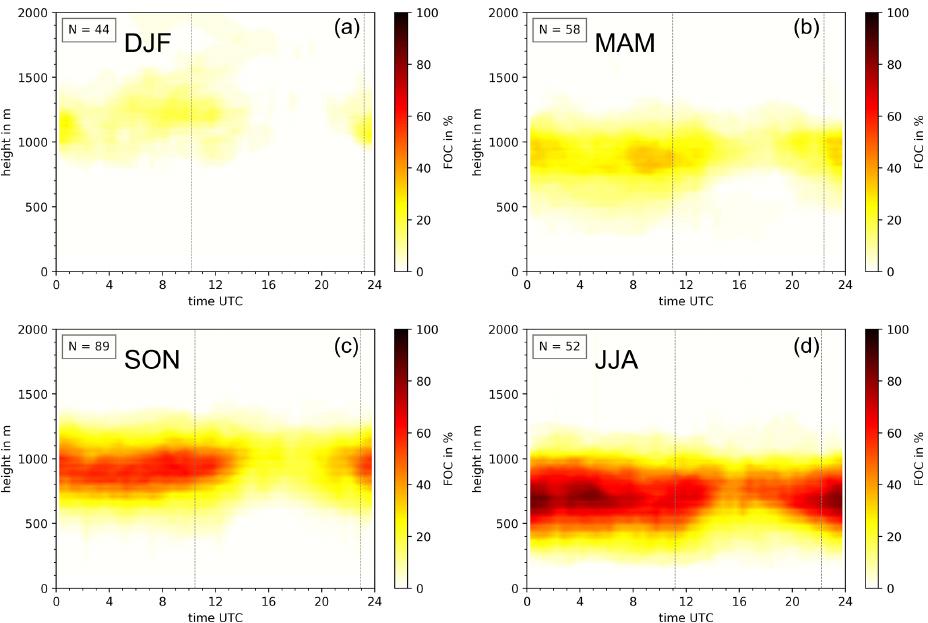
Figure 6. Frequency of occurrence (FOC) of clouds with cloud base below 2kma.s.l. in time × height bins during different seasons. Clock- wise: (a) austral summer (DJF), (b) fall (MAM), (d) winter (JJA) and (c) spring (SON). The value of N gives the number of days analyzed. Vertical dashed lines indicate the average times of sunrise and